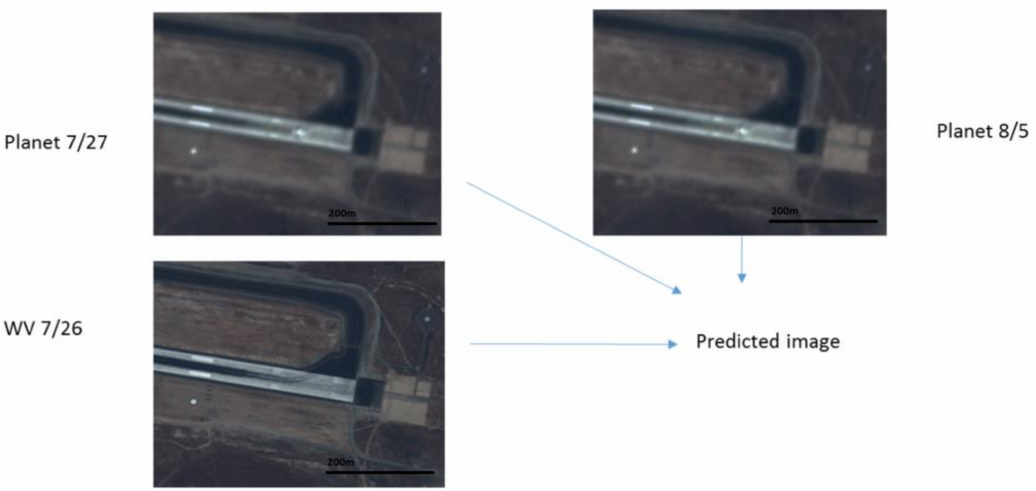
Figure 11. Two Planets images at 27 July and 5 August and one WV image at 26 July are fused to generate a prediction. The prediction is then compared to a WV image collected on 3 August 2017. Table 7. Comparison of prediction results of using Planet and WV images for the scenario depicted in Figure 11. RGB R Runway